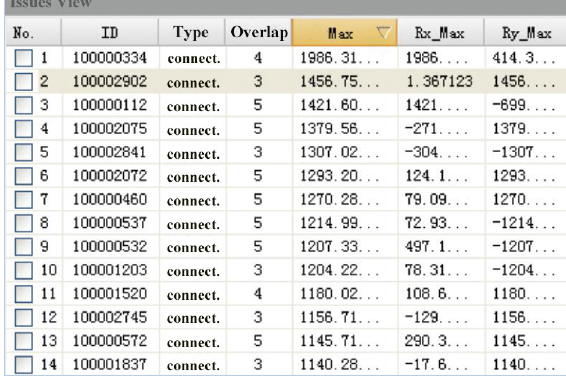
Figure 8. Screening of the connection